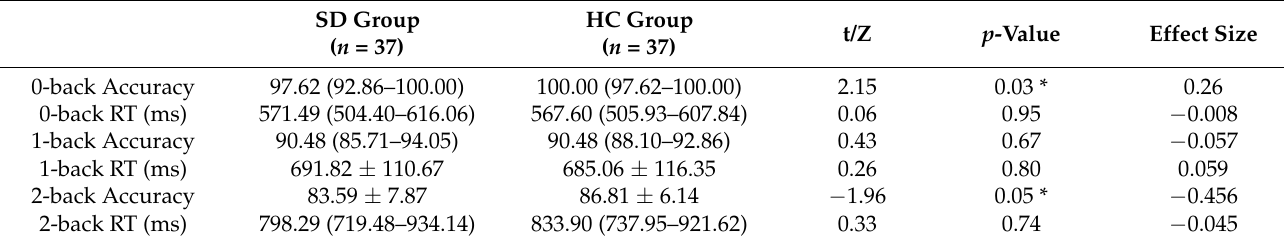
Table 3. N-back tests performance of SD group and HC